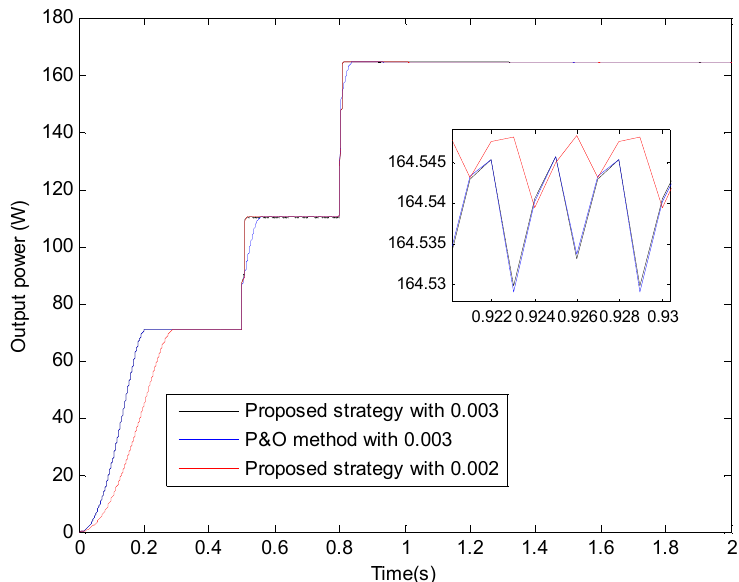
Figure 32. Compared power curves under different step size conditions. Table 9. Simulation parameters and results corresponding to Figures 30–32.